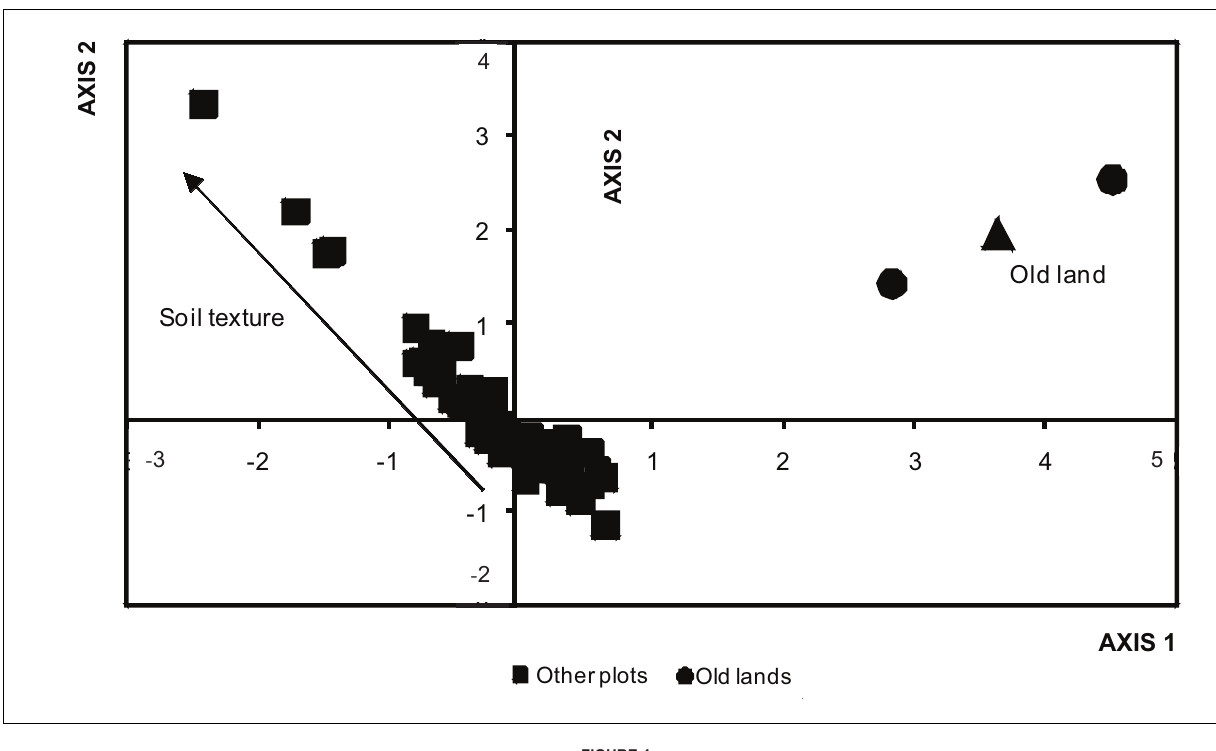
FIGURE 4 CCA ordination biplot of 64 vegetation sample plots in the Parque Nacional Zinave, with the spread of samples aligned along a gradient of increasing clay content in the soil and where the CCA excluded sample plots along major drainage lines, on floodplains and on termite mounds, by using one quantitative (soil texture) and one nominal (land-use history) environmental variable